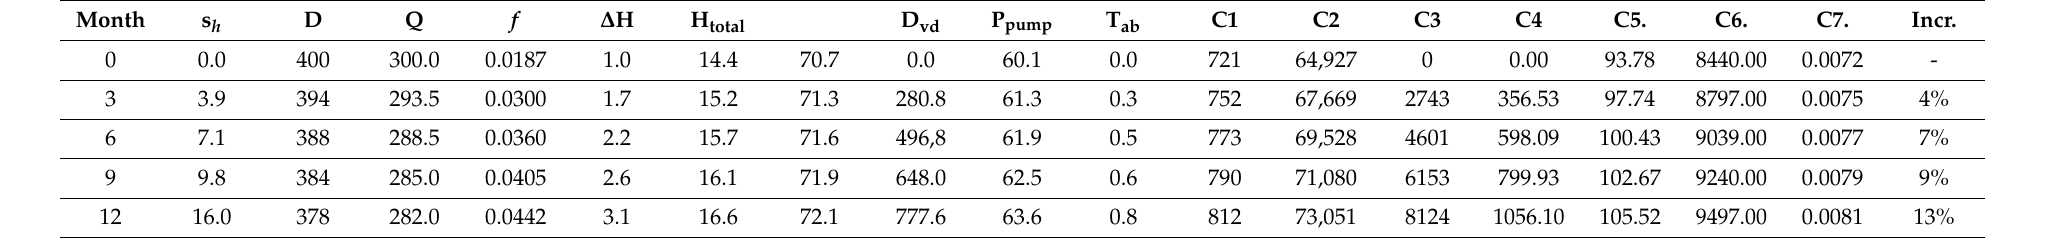
Table 5. Progression of consumption and costs, in view of the progression of GM bioinfestation for Pump 2, with a flow rate of 300 L/s and a diameter of 400